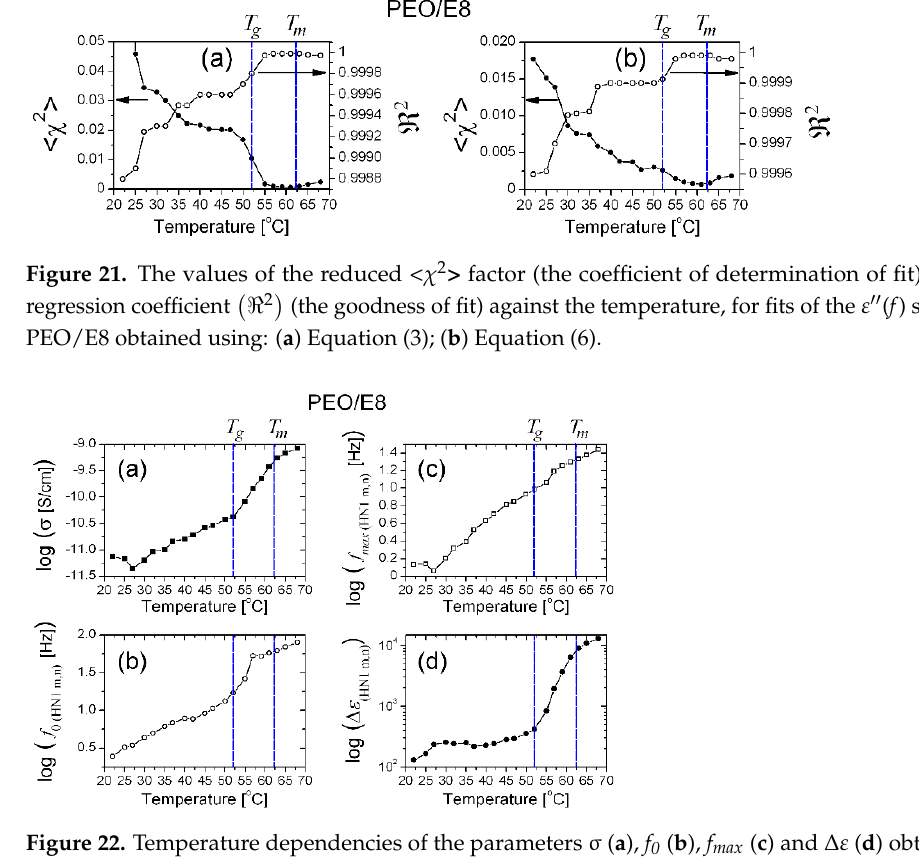
Figure 20. Fits on the ε ″ ( f ) spectra of PEO/E8 using Equation (6). The ε ″( f ) spectra correspond to temperature 22 °C ( a ); 25 °C ( b ); 45 °C ( c ); 52 °C ( d ); 55 °C ( e ); 68 °C ( f ). The ε ″ spectral data are represented by the symbol (X); the blue, the green, and the yellow lines of the best fits on the ε ″ data are the contributions of the two HN functions in the term and the single HN term in Equation (6), respectively; the straight line represents the contribution of the conductivity term; the envelope 𝑑𝑑𝑑𝑑𝑑𝑑″ 𝜀𝜀 of the four spectral components’ curves (the total fit) is colored in red. The values of the reduced < χ 2 > factor and the regression coefficient are also shown. 2 ( ℜ )